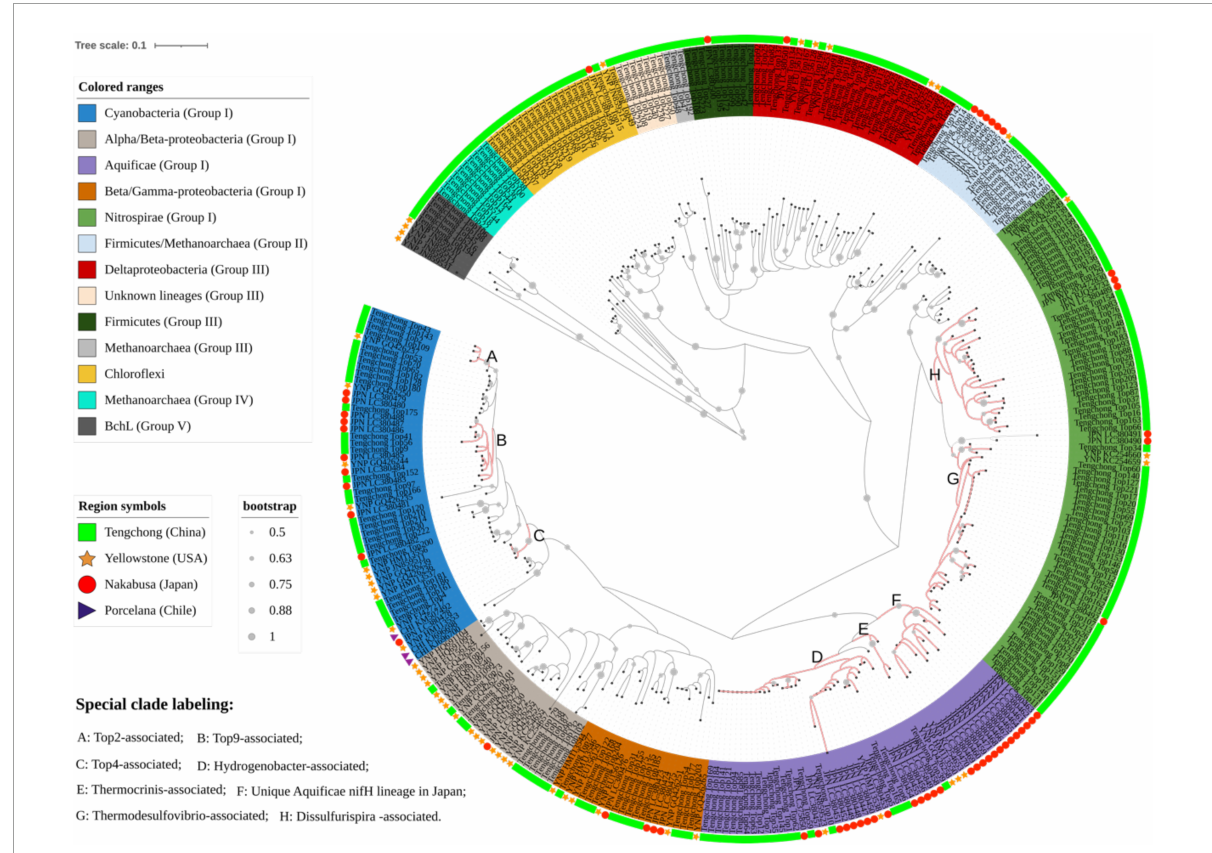
FIGURE3 A Neighbor-joining tree showing the phylogenetic relationships between the nifH gene sequences obtained in this study and those from Yellowstone, Chile, Japan hot